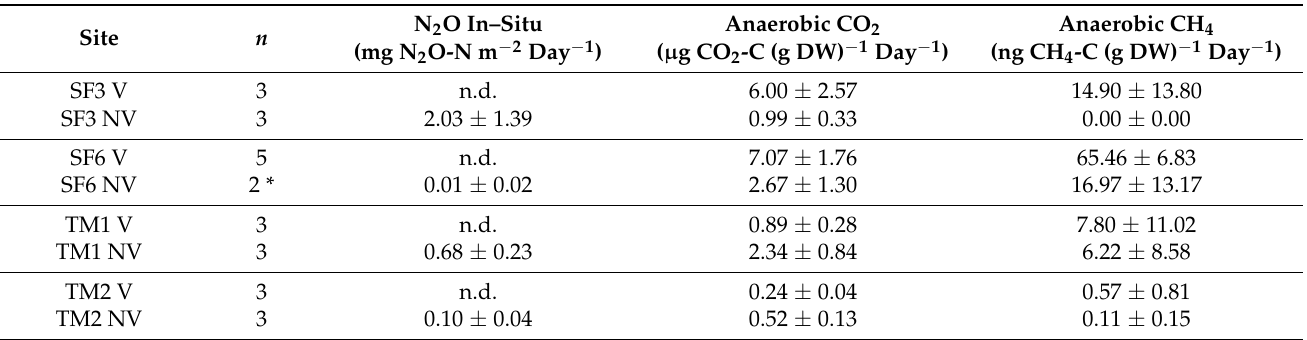
Table 4. In–situ N 2 O fluxes from July 2019 and CO 2 and CH 4 production rates from an anaerobic incubation (4 ◦ C) of revegetated (V) and non-vegetated (NV) slump floor (SF) and thaw mound (TM) soils ( n = number of replicates). Dates of in–situ sampling are given in the Supplementary Material (Table